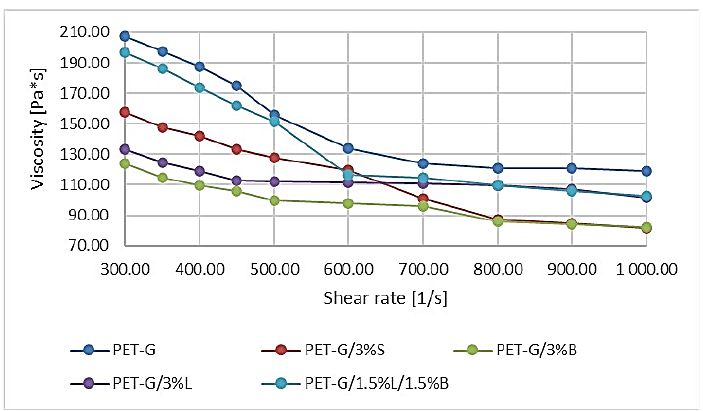
Figure 3. Viscosity curves of PET-G polymer and composites based on PET-G.